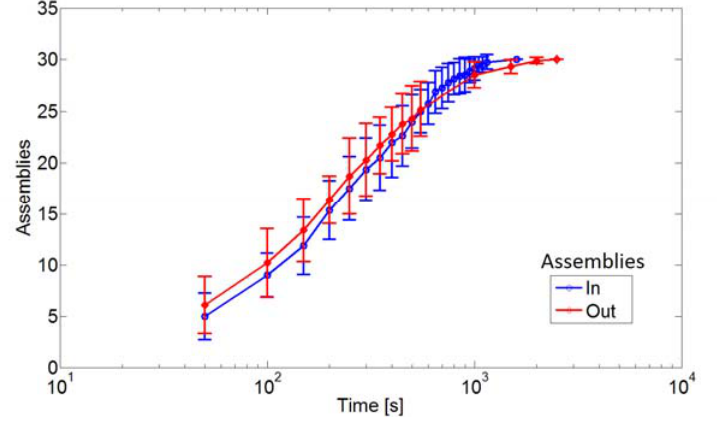
Figure 9. Simulated effects of inert dimers (resulting from assembly) on fl uidic SA performance: for the out (in) case, the dimers are (not) removed from the assembly space after assembly (ABM parameters: 10× smaller assembly space; initial populations: 60 LEDs and 30 carriers, θ = 80°, initial agents velocity: 100 mm/s; statistics out of CCS 10 realizations for each